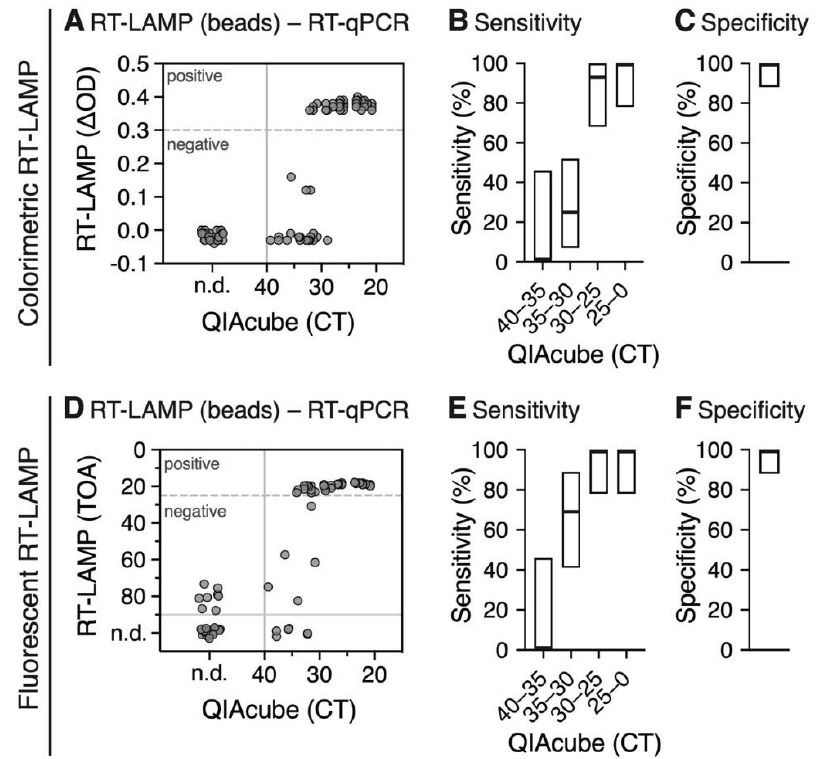
Figure 5. Analysis of colorimetric ( A – C ) and fluorescent ( D – F ) RT-LAMP of RNA extracted using the magnetic bead RNA extraction protocol compared to RT-qPCR CT values obtained from RNA isolated by the QIAcube extraction. ( A ) Scatter plot shows optical density di ff erences obtained from colorimetric RT-LAMP ( ∆ OD = OD 434nm − OD 560nm ) at a time point of 30 min. The ∆ OD threshold of 0.3 is indicated as a dashed line. All samples with a CT > 40 were considered as negative (solid line); n.d., not determined. ( B , C ) Sensitivity ( B ) and specificity ( C ) of colorimetric RT-LAMP for di ff erent CT ranges. The boxes indicate the 95% Clopper-Pearson confidence interval (Supplementary Table S2). ( D ) Scatter plot shows time of amplification (TOA) in min for each sample obtained from fluorescent RT-LAMP compared to RT-qPCR CT values obtained from RNA isolated by the QIAcube extraction. The TOA threshold of 25 min (dashed line) was used to define positive and negative samples from RT-LAMP. All samples with a CT > 40 and TOA > 25 min were considered as true negative (solid lines). ( E , F ) Sensitivity ( E ) and specificity ( F ) of fluorescent RT-LAMP for di ff erent CT ranges. The boxes indicate the 95% Clopper-Pearson confidence interval (Supplementary Table S3).